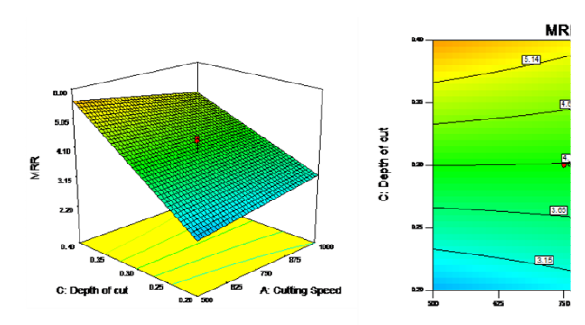
Fig. 10: 3D Response and Contour pot of Material Removal Rate Vs Cutting Speed and Depth of Cut value of the depth of cut with increasing feed rate the MRR will be increased suggestively and vice versa.